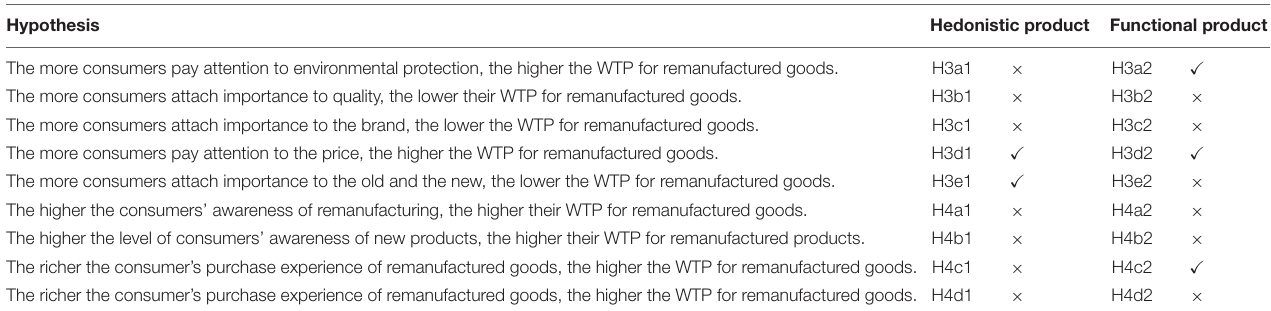
TABLE 10 | Test results of the hypothesis for consumers’